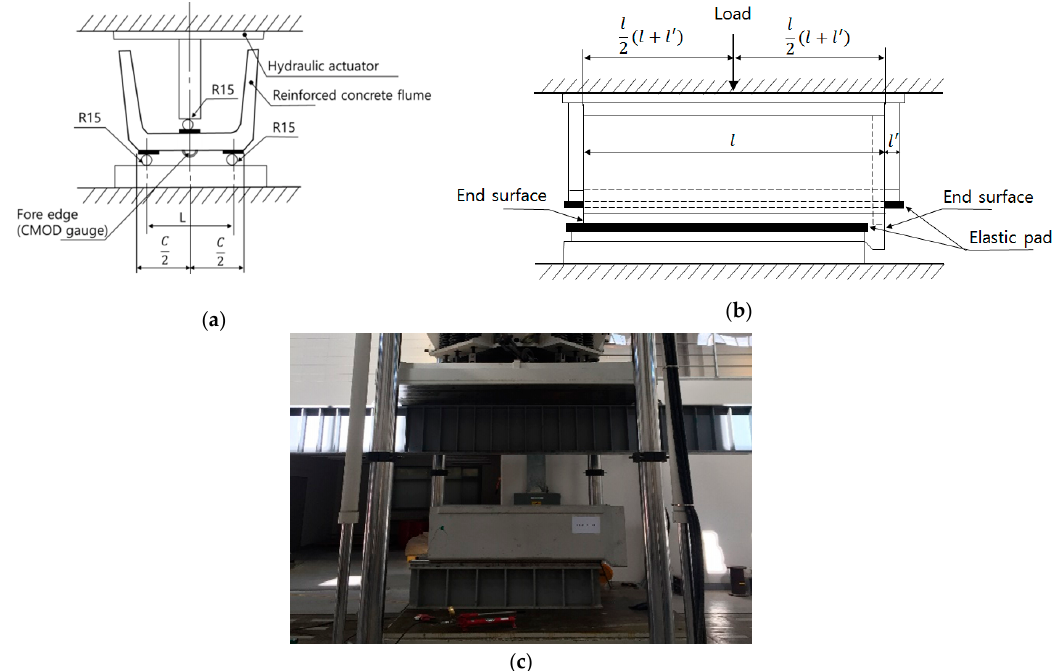
Figure 3. Test method of the LWGP concrete flumes from KS F 4010. ( a ) Cross section; ( b ) Longitudinal section; ( c ) The test setup for the LWGP concrete flume.